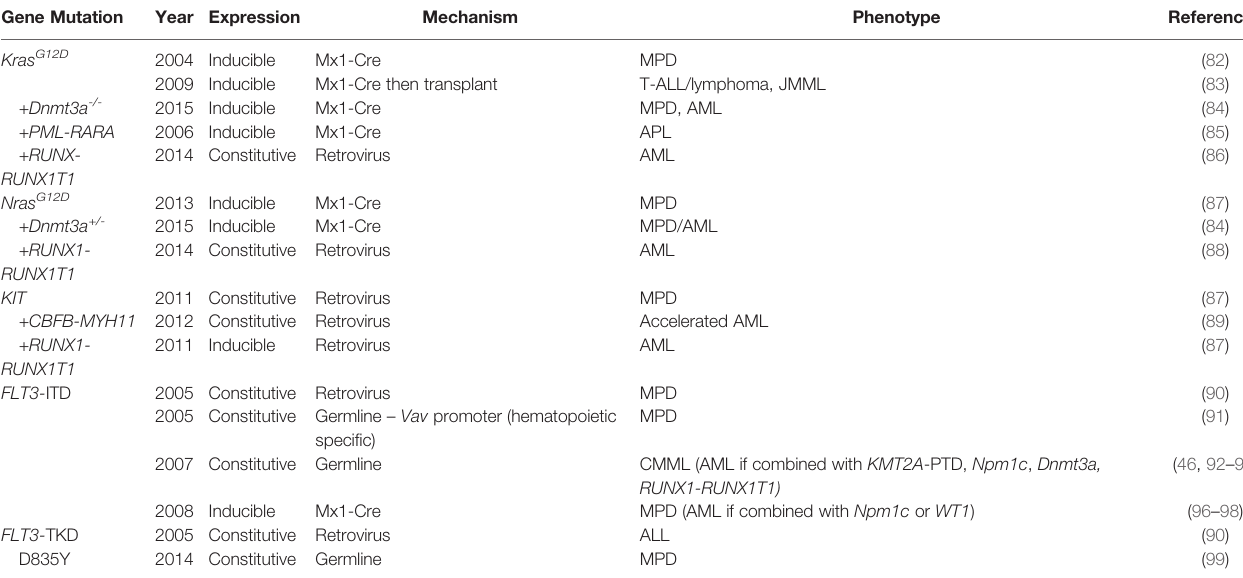
TABLE 2 | Mouse models of signal transduction